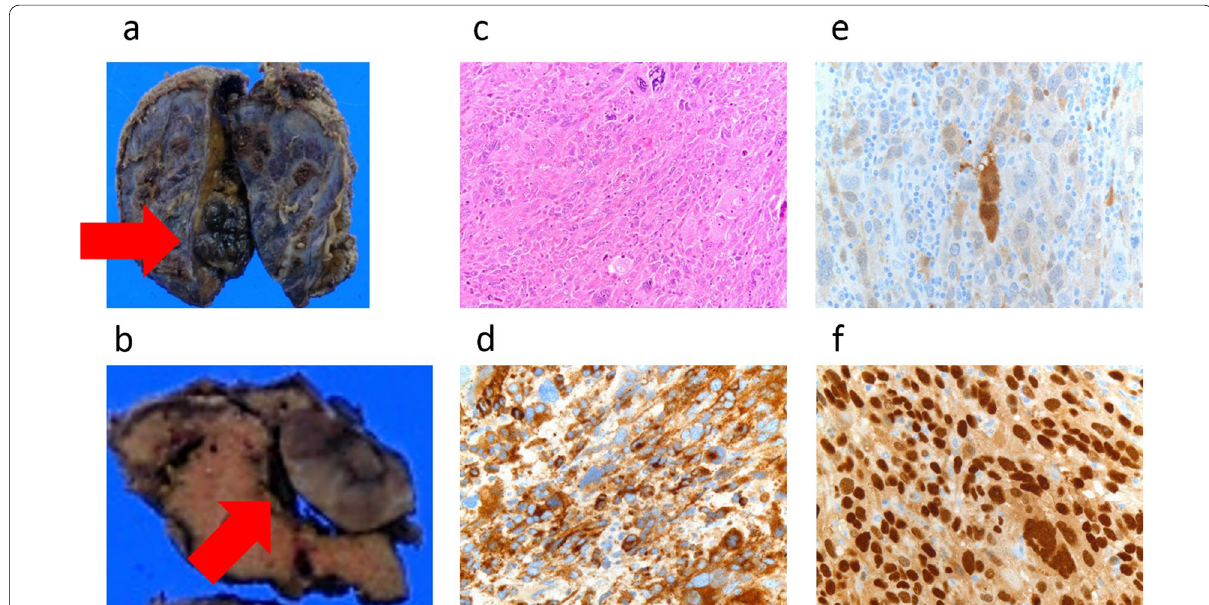
Fig. 4 Macroscopic findings, histopathological findings, and immunostaining findings of the liver metastasis. a , b Pathological specimens revealed a 16-mm-diameter solid nodule accompanied by melanin depositions. c Histopathological findings demonstrated diffuse proliferation of atypical cells with prominent nuclei of varying size accompanied by melanin deposition. d Positive for HMB-45. e Positive for S-100. f Positive for